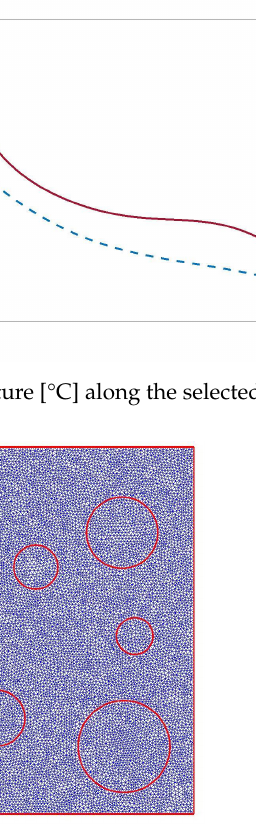
Figure 10. Fine mesh within a coarse